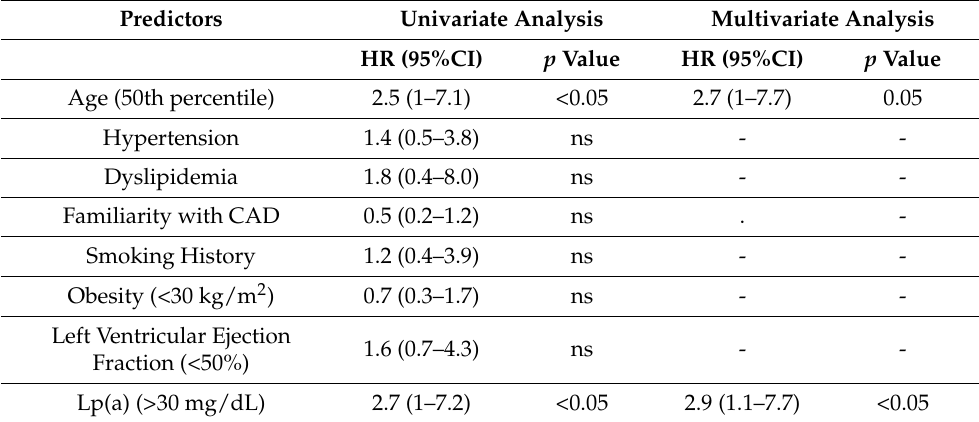
Table 3. Univariate and multivariate COX analysis for HEs in T2D female patients.